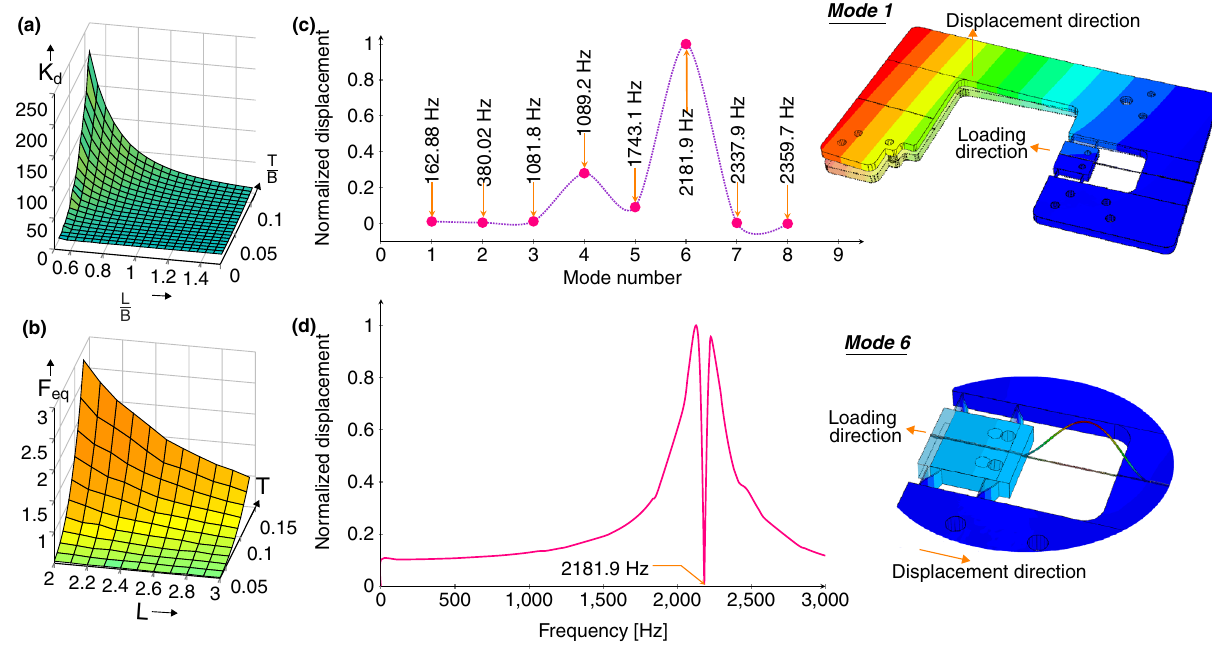
Figure 2. ( a ) The influence of geometrical parameters on K d ; ( b ) Geometrical value selection based on F eq ; ( c ) Eigen frequencies of the new device; ( d ) The modal analysis of the system for mode six (2181.9 Hz). [ Graphs are generated using latex-pgf plot package, FE models for ( c ) and ( d ) are generated using Abaqus Standard/Explicit software, version 2017, https:// www. 3ds. com/ produ cts- servi ces/ simul ia/ produ cts/